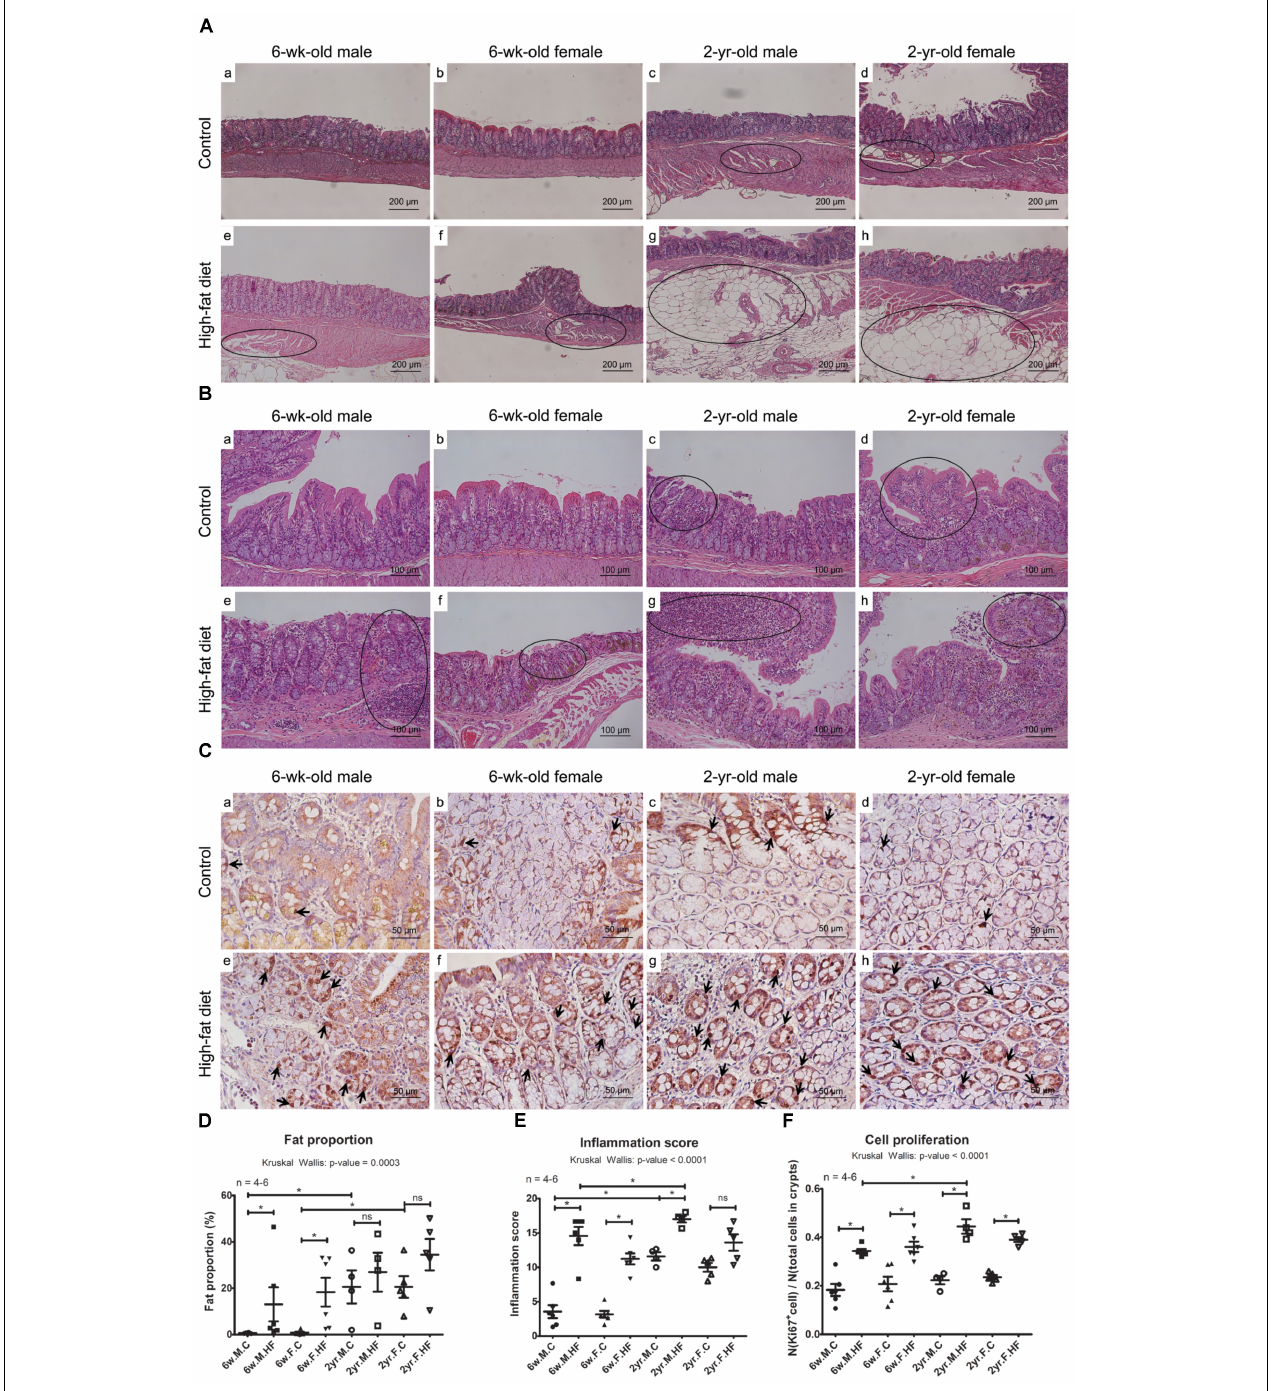
FIGURE 5 | Histological analysis of colonic tissues. Fat deposition (A) and inflammation (B) in the photomicroscopy of H&E stain of ascending colons ( A : × 200 magnifications; B : × 100 magnifications). Dotted circles represent regions with fat deposition or inflammation. (C) Immunohistochemical images of Ki67 ( × 400 magnifications). Arrows indicate representative Ki67-immunoreactive cells. (D) Fat proportion (%) in total smooth muscle area. (E) Inflammation scores of colonic epithelial damage and inflammatory cell infiltration in mucosa, submucosa, and muscle layers. (F) The Ki67 proliferation index calculated by dividing the number of Ki67-stained cells with the number of total cells within all crypts. Scatter plot (mean, SEM) (6-week-old rats, n = 6; 2-year-old male rats, n = 4; 2-year-old female rats, n = 5). p -Values to Kruskal–Wallis test is designated on the figure; ∗ p < 0.05 according to Mann–Whitney U -test with Holm–Bonferroni correction. M, male; F, female; C, control; HF, high-fat diet; Control groups of 6-week-old male (a) , 6-week-old female (b) , 2-year-old male (c) , 2-year-old female (d) , and high-fat diet groups of 6-week-old male (e) , 6-week-old female (f) , 2-year-old male (g) , and 2-year-old female (h) .